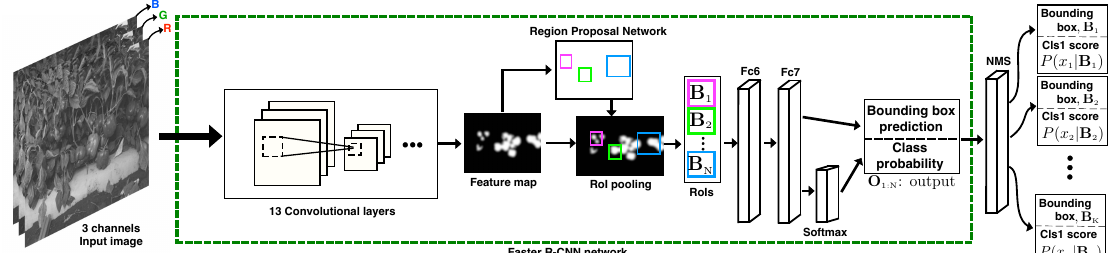
Figure 3. Illustration of test time the Faster Region-based Convolutional Neural Network (R-CNN). There are 13 convolutional and 2 fully-connected (Fc6 and Fc7) and one softmax classifier layers. N denotes the number of proposals and is set as 300. O is the output that contains N bounding 1: N boxes and their scores. Non-Maximum Suppression (NMS) with a threshold of 0.3 removes duplicate predictions. B is a bounding box of the K -th detection that is a 4 1 vector containing the coordinates K × of top-left and bottom right points. x K is a scalar representing an object being detected.